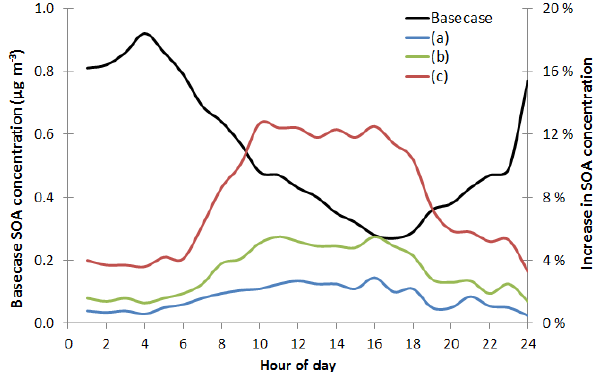
Figure 11. Domain-wide average SOA concentrations in the base case (black line, left axis) and the relative increase in domain-wide average SOA concentrations (right axis) driven by the oxidation of indole by OH in the (a) low emission scenario, (b) medium emis- sion scenario, and (c) high emission scenario. Figure S6 addition- ally shows the effect of inclusion of the indole + NO 3 reaction on the